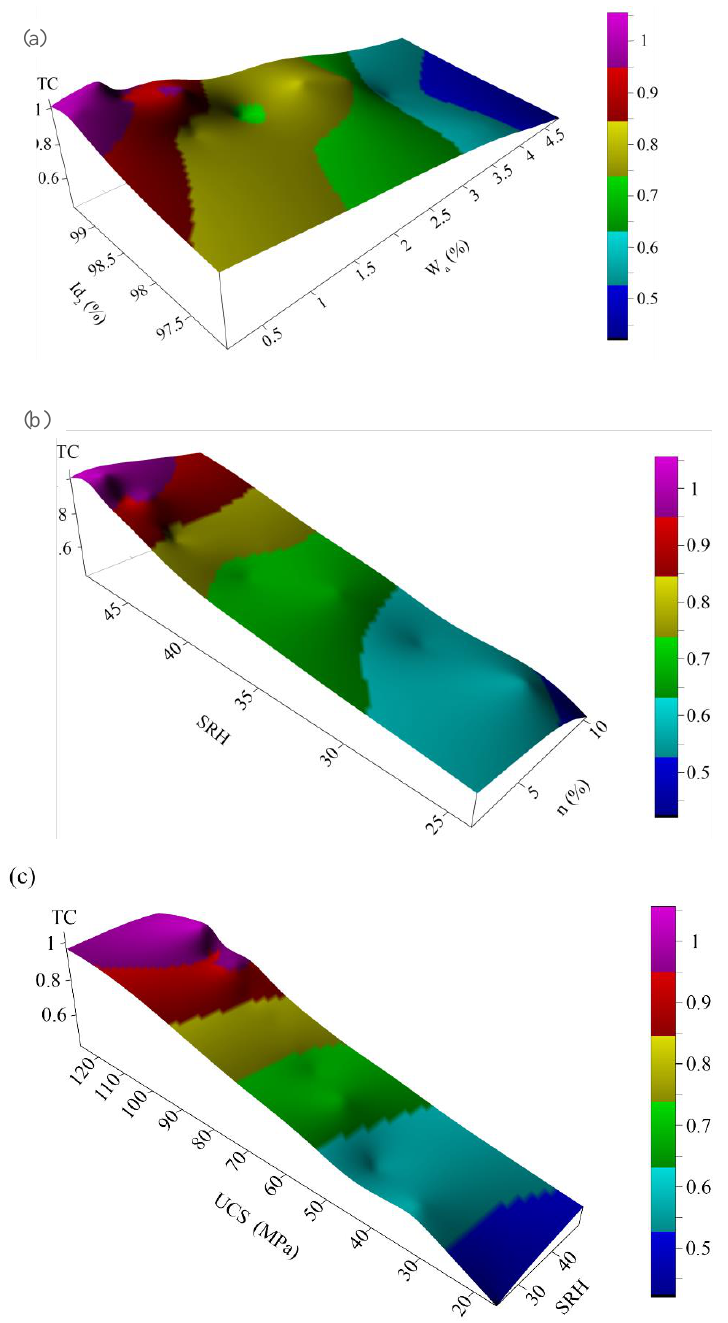
Figure 10. Three-dimensional view of the correlations among ( a ) texture coefficient (TC), slake durability index (Id 2 ) and water absorption (W a ); ( b ) texture coefficient (TC), Schmidt rebound hardness (SRH) and porosity; ( c ) texture coefficient (TC), uniaxial compressive strength (UCS), and Schmidt rebound hardness (SRH).